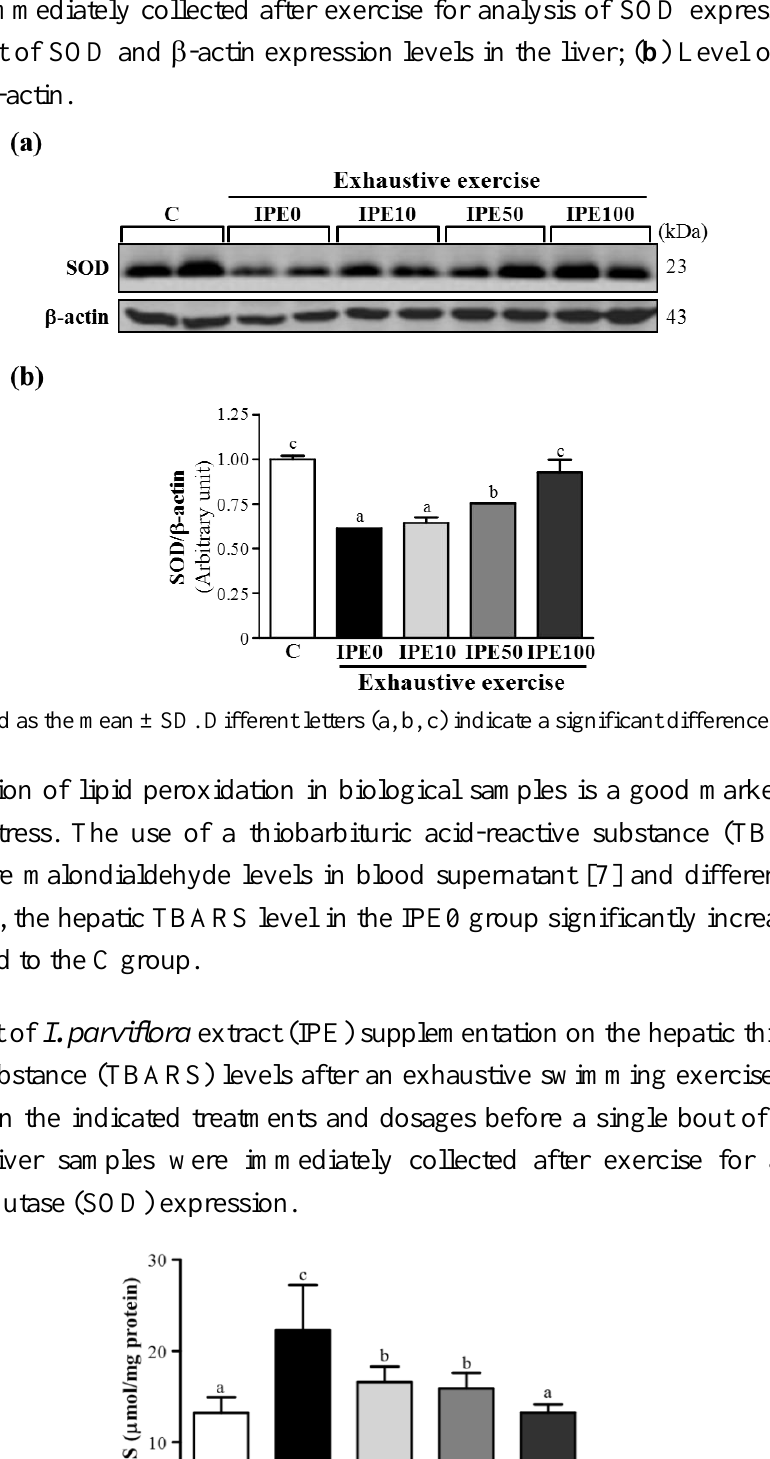
Figure 1. Effect of I. parviflora extract (IPE) supplementation on the hepatic superoxide dismutase (SOD) levels after an exhaustive swimming exercise challenge. Mice were given the indicated treatments and dosages before a single bout of exhaustive exercise, and liver samples were immediately collected after exercise for analysis of SOD expression levels.